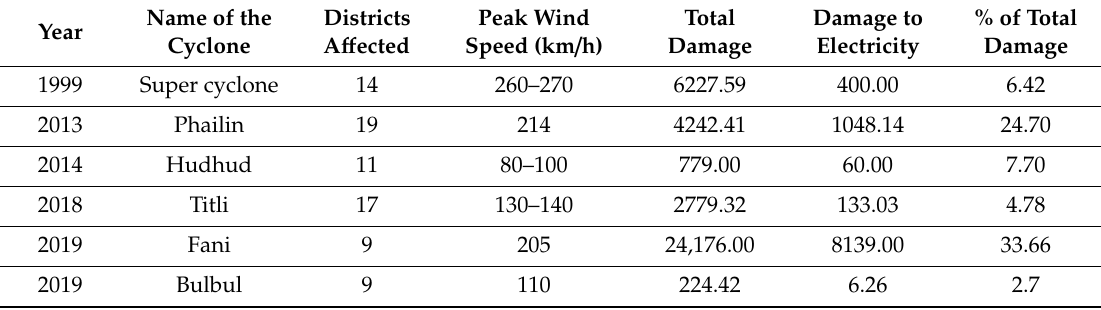
Table 1. Total Damage and Damage to Power Sector by Cyclones (in INR crores).